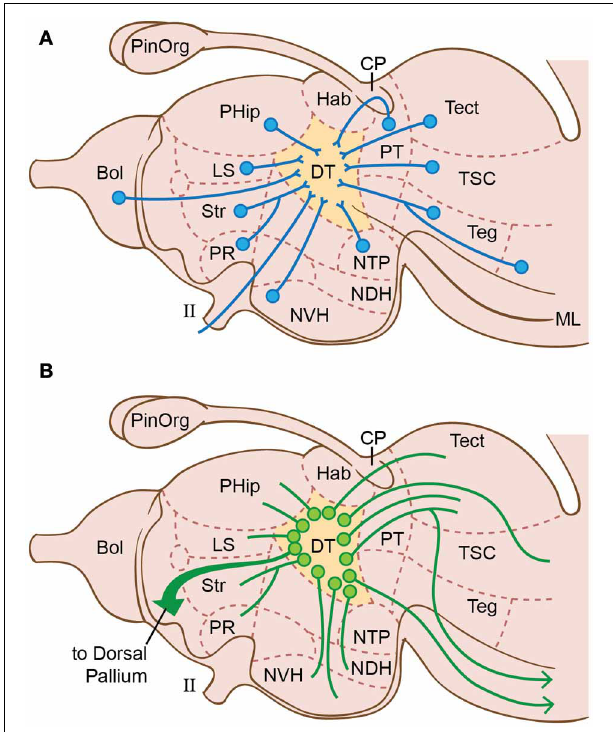
FIGURE 7 | Brain regions in lampreys, emphasizing the connections of the dorsal thalamus (DT) according to Nieuwenhuys (1972); Nieuwenhuys (1977) and Nieuwenhuys and Nicholson (1998). (A) Afferents to dorsal thalamus. (B) Efferents from dorsal thalamus. II, optic nerve; Bol, olfactory bulb; CP, commissura posterior; Hab, ganglion habenulae; LS, lobus subhippocampalis; ML, medial lemniscus; NDH, nucleus dorsalis hypothalami; NVH, nucleus ventralis hypothalami; NTP, nucleus tuberculi posterioris; PinOrg, pineal organ; PHip, primordium hippocampi ( = hippocampus, medial pallium); PR, nucleus preopticus; Str, corpus striatum; PT, area pretectalis; Tect, tectum mesencephali; Teg, tegmentum; TSC, torus